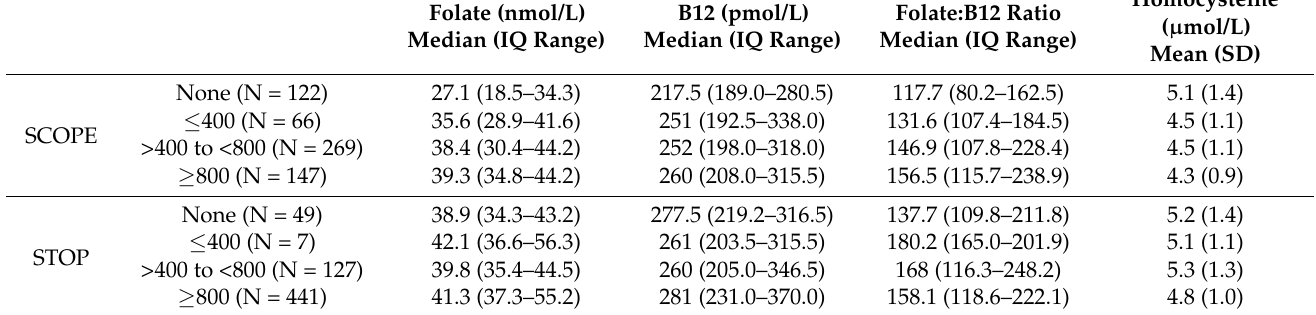
Table 2. Blood biochemistry measures of one-carbon metabolism variables in SCOPE (14–16 weeks of gestation) and STOP (6–16 weeks) women with uncomplicated pregnancies according to daily FA supplementation